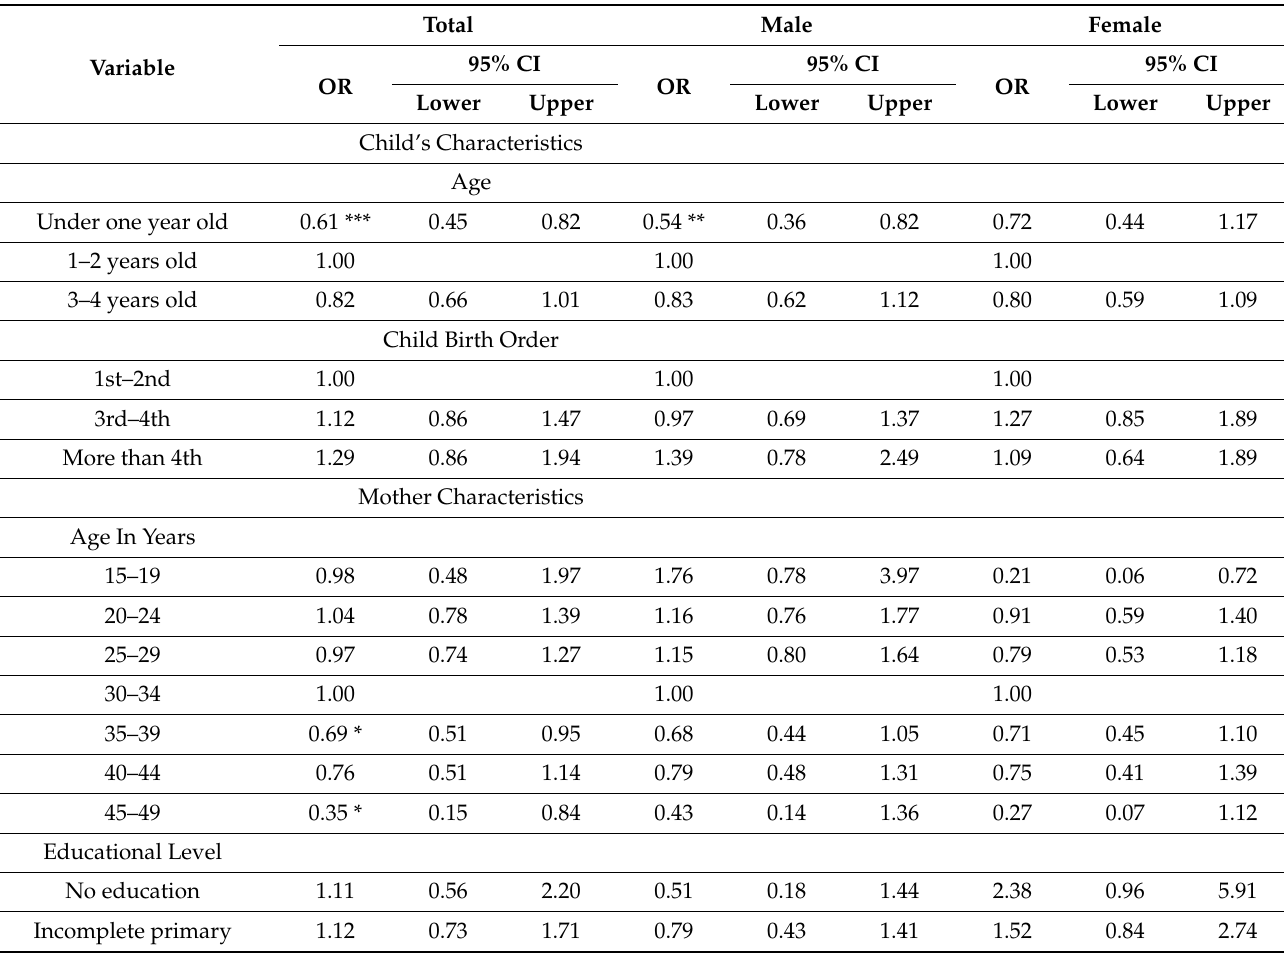
Table 5. Predictions of children with ARI symptoms in Indonesia compared by gender in